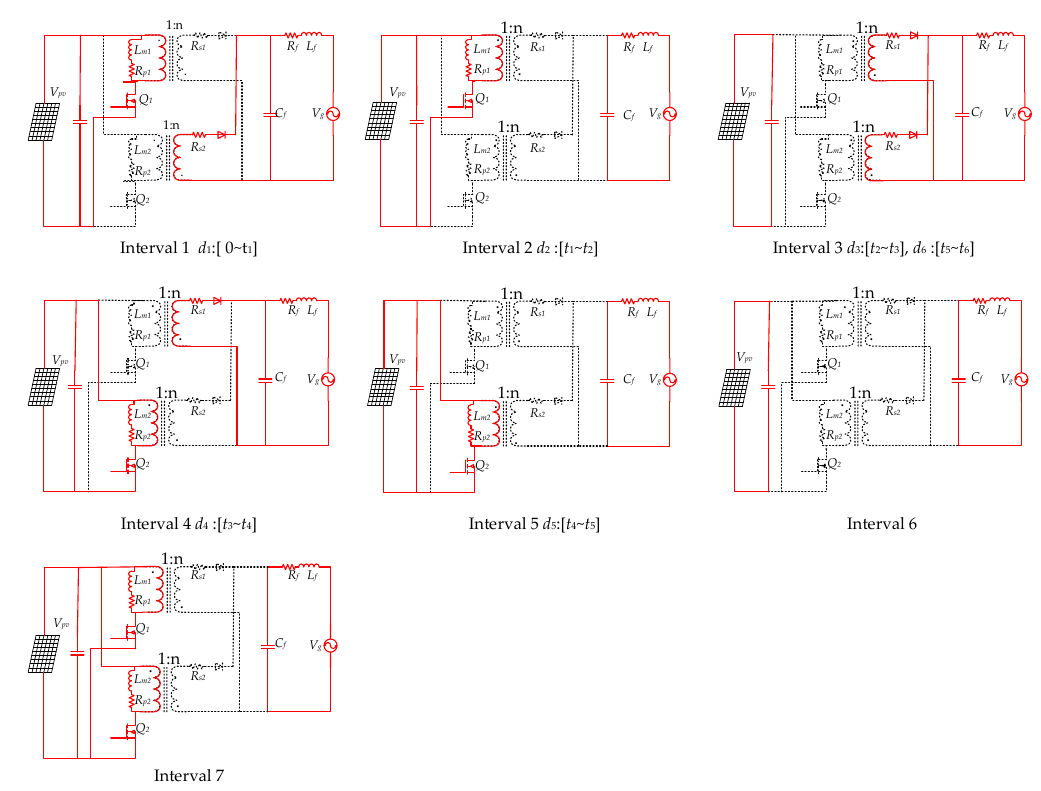
Figure 3. Equivalent circuits for different intervals in steady-state operation.